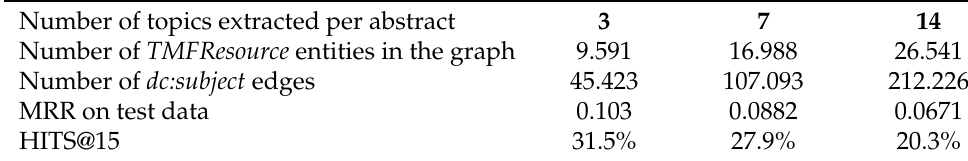
Table 4. Impact of the number of topics present in the RDF graph on the accuracy of the trained model. Number of topics extracted per